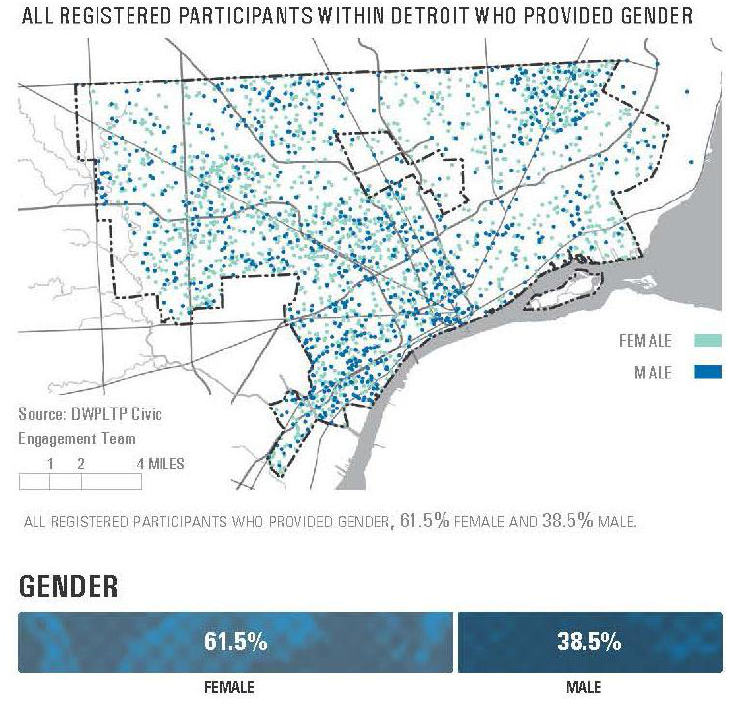
Figure 8. Map of all registered participants of DWPLTP within Detroit who provided gender. (Image credit: Detroit Future City: 2012 Detroit Strategic Framework